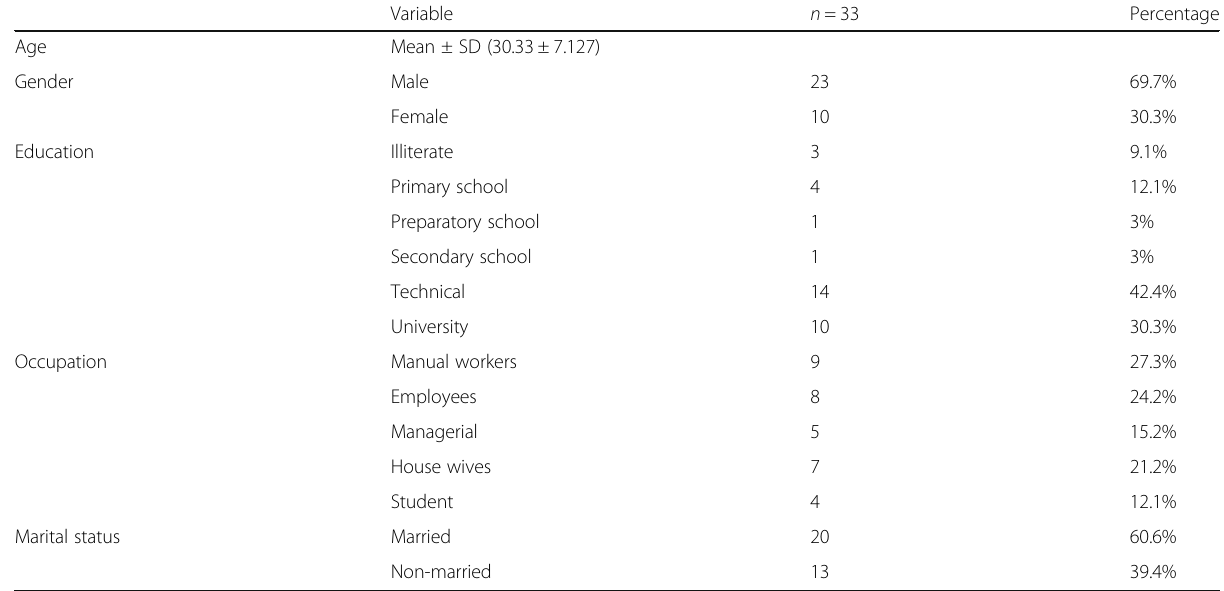
Table 1 Socio-demographic data of the donors